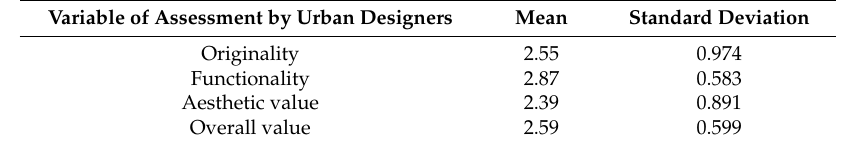
Table 3. The means and standard deviations of the creativity variables assessed by the urban